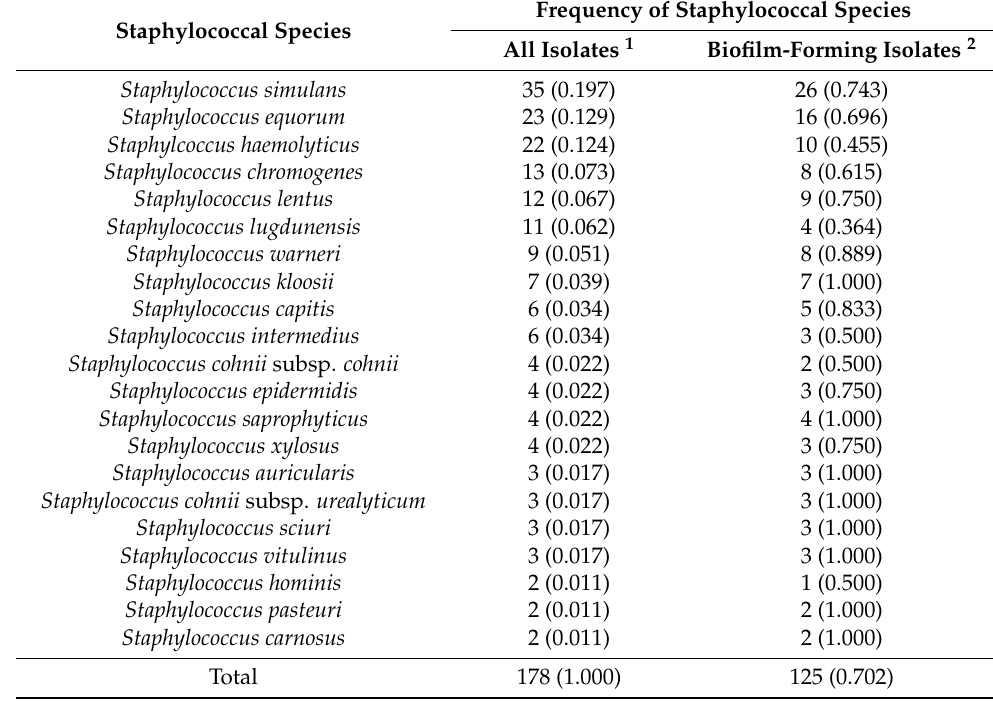
Table 1. Frequency of coagulase-negative staphylococcal species recovered from bulk-tank milk of 325 sheep flocks in Greece.